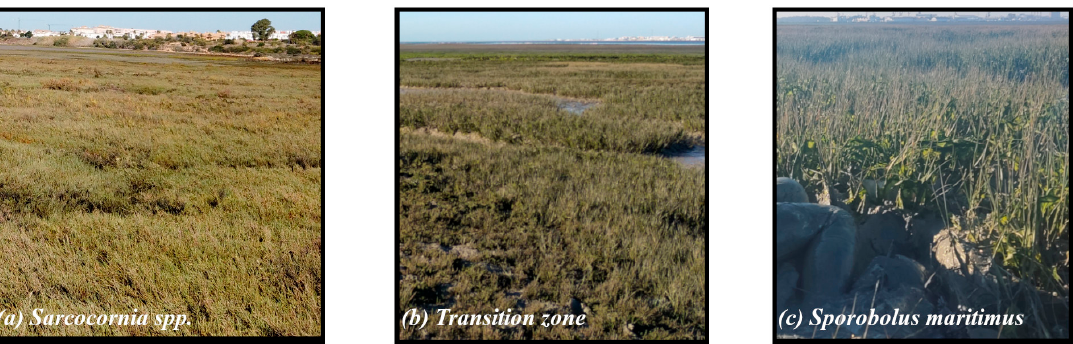
Figure 2. Landscapes with dominant vegetation throughout the salt marsh horizons. ( a ) Sarcocornia spp. populate the medium salt marsh horizon. ( b ) The vegetation of medium and low horizons overlaps in a narrow fringe here called the transition zone. The abundance of species from the me- dium and the low horizons can be found in different proportions. ( c ) Sporobolus maritimus dominates the low horizon of the salt marsh.